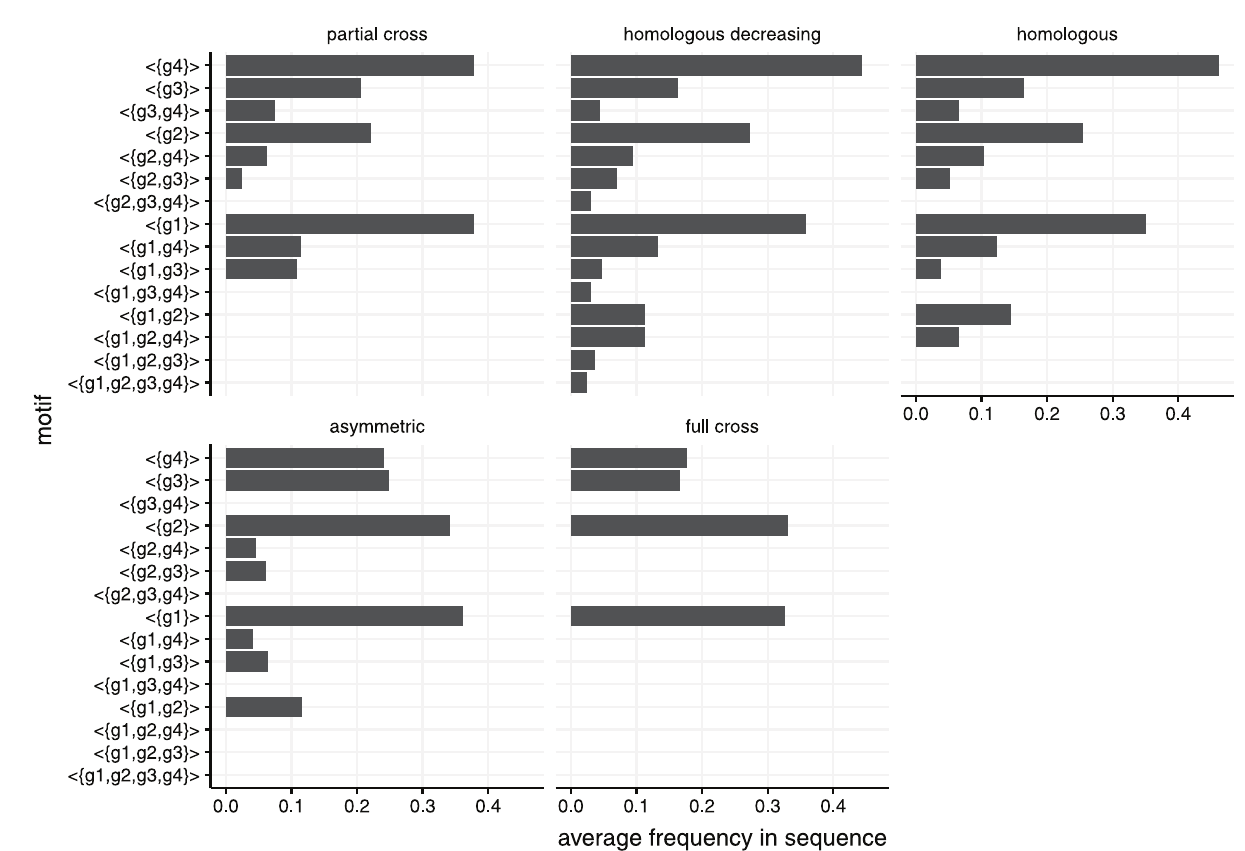
Fig 7. Effect of cross-immunity patterns on the average frequency of all possible sequence motifs with length one. The motifs represent cross- sectional multiple infection snapshots. Here, samplings are performed at five random time points during the simulation. Note that coinfection by all 4 genotypes is only found in the homologous decreasing case. The corresponding cross-immunity matrices are shown in the Materials and methods. See also Fig 6 for additional information regarding co-occurrence between the genotypes.